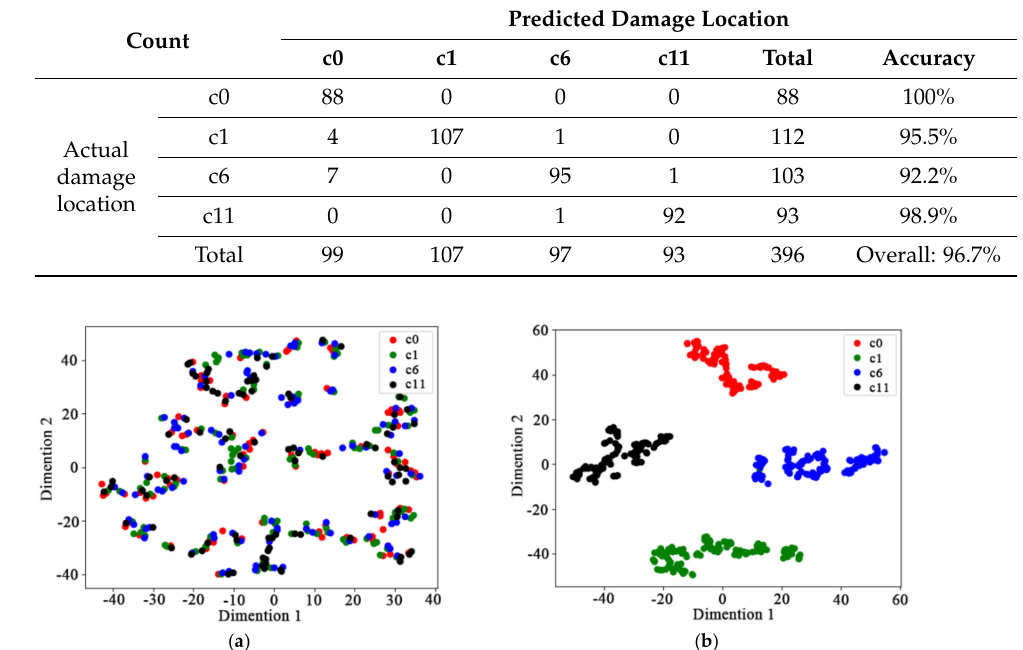
Table 3. The test results.